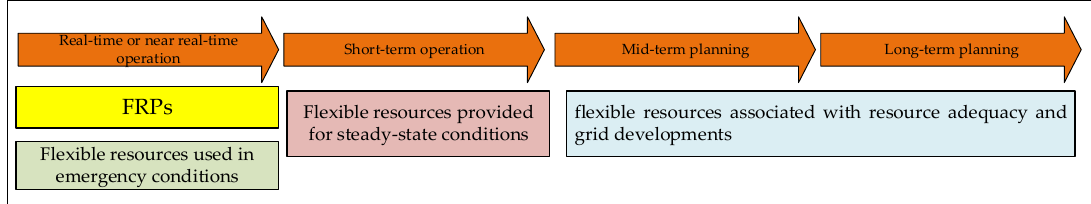
Figure 2. Operation and planning timeframes for TSO-level flexibility trading.